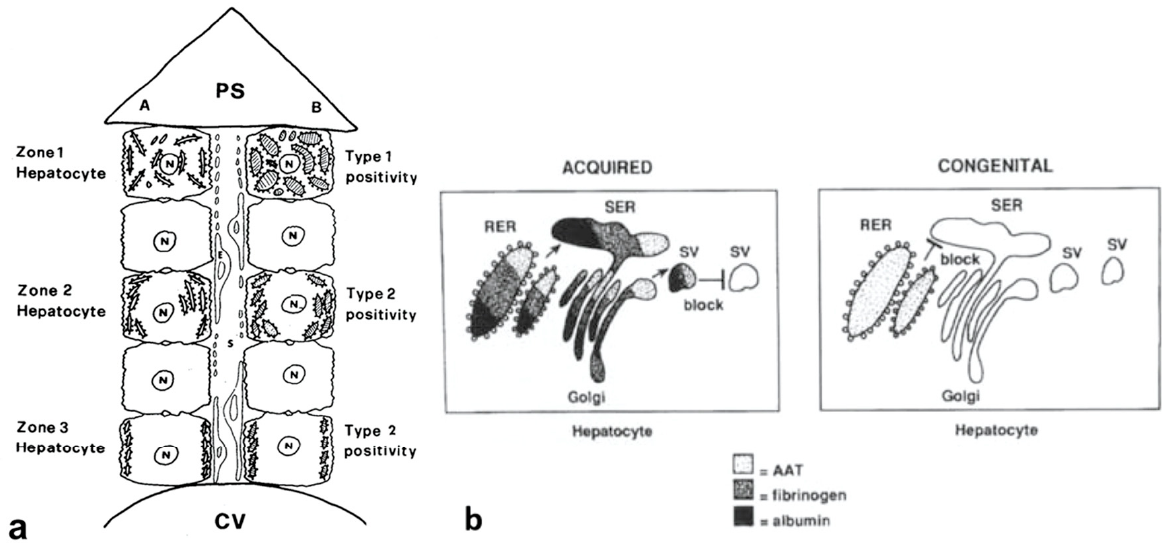
Figure 11. Schematic representation of amount and distribution of the RER in hepatocytes, and “R-SB” phenomenon in hepatic lobule, according to a lobular (portal-central) gradient. A and B represent liver cell muralia. PT = portal tract. CV = central vein. The full cytoplasmic granular staining corresponds to type I positivity. Crescents and double row staining correspond to type II positivity. ( a ) Schematic representation of acquired vs. congenital defects of protein secretion. The acquired defects of protein secretion are due to exogenous agents that block the migration of secretory vesicles (CV) and cause a collective retention of secretory proteins. The congenital defects affect mutant proteins and cause a selective and exclusive retention of a given mutant protein in the early stage of synthesis within the RER ( b